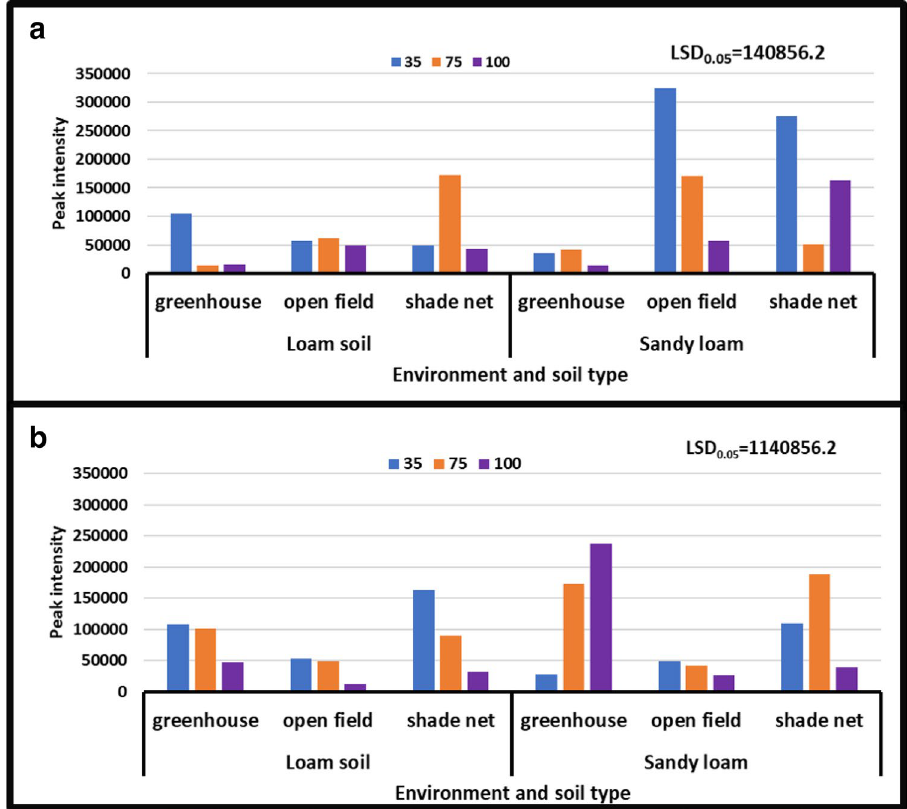
Figure 3. Treatment interaction effect on Dopa of African horned cucumber fruit. Values are average over treatment; 35 means severe water stress; 75 means moderate water stress; 100 means no water stress; ( a ) means treatment interaction of water stress levels and soil types at different environments during the 2017/18 season; ( b ) means treatment interaction of irrigation water regimes and soil types at different environments during the 2018/19 season. Peak intensity showing LCMS-8040 triple quadrupole mass spectrometer intensities which represent the quantity of metabolites varying with treatments. LSD 0.05 is the least significant difference of